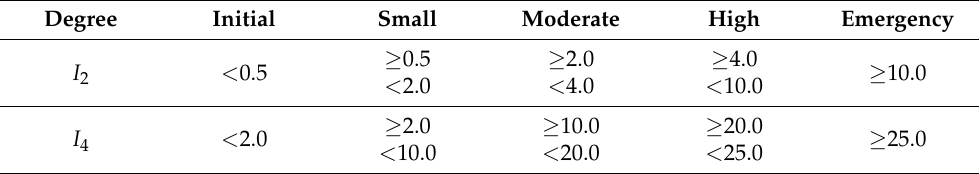
Table 3. Degrees of fault